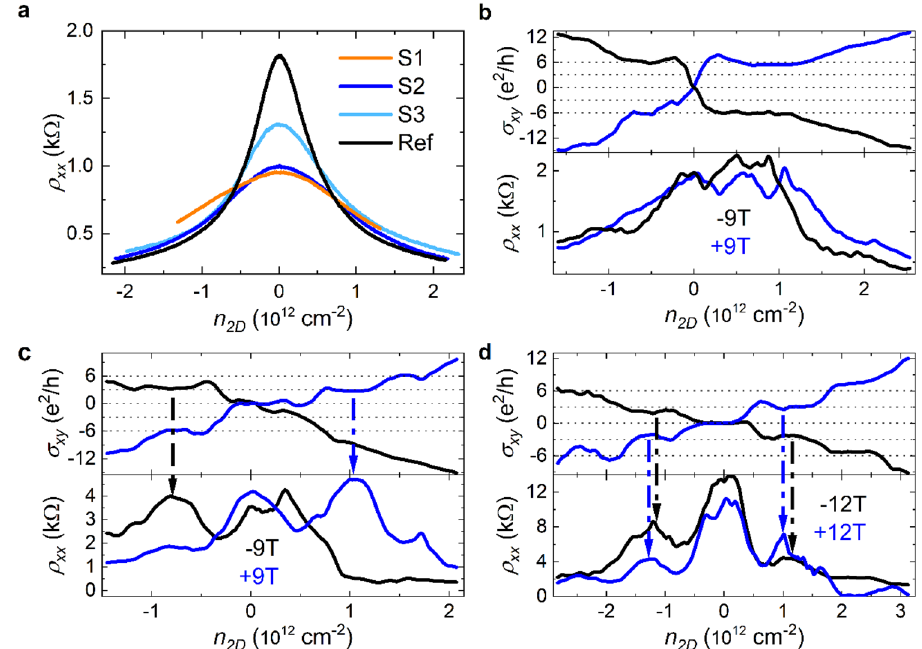
Figure 3. Electrical (magneto-)transport measurements of graphene/TCNQ samples at room temperature and liquid helium temperature: ( a ) Longitudinal resistivity ρ xx at room temperature of all samples including a reference sample with no TCNQ deposited. The ambipolar behavior of graphene is clearly found in each. Magnetotransport measurements ( b – d ) of the samples S1 to S3 were carried out at liquid helium temperature. Transverse conductivity σ xy and ρ xx measured at magnetic fields of 9 T (S1 & S2) and 12 T (S3). ( b ) ± ± S1 shows plateau indicating kinks with zero σ xy and a corresponding maximal ρ xx at the CNP. We note, that for a considerably disordered system as S1, an asymmetric transport behavior with respect to the CNP showing additional features can be expected 56 . ( c ) S2 exhibits a clear local maximum in ρ xx accompanied by a 2 ρ xx backed by unconventional pronounced plateau at σ xy = 0 e h for both field directions. Additionally, maxima in 3 e 2 6 e 2 σ xy plateaus at σ xy h are observed (indicated by dashed arrows). Finally, plateaus at h appear = + = ± together with local minima in ρ xx for large n 2 D , designating them as quantum Hall states. ( d ) For S3,